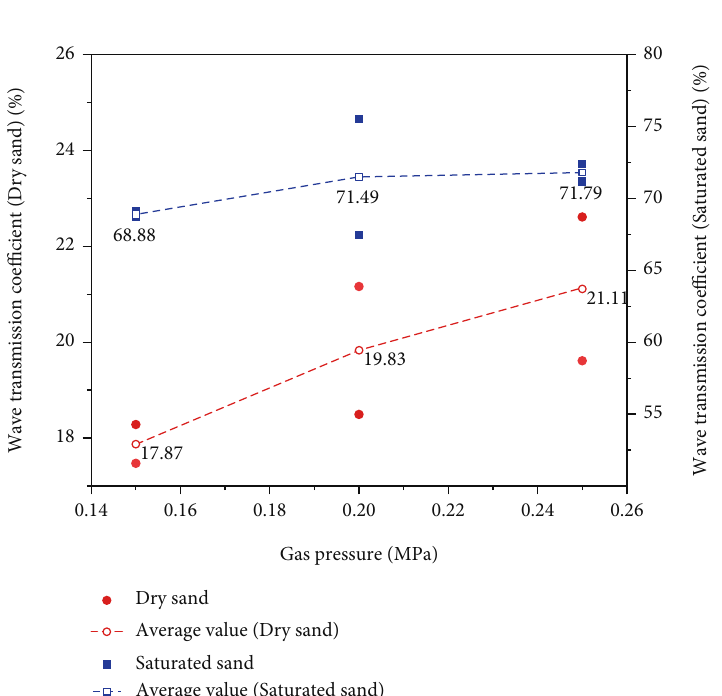
Figure 5: Variation curve of the transmission coe ffi cient under di ff erent working